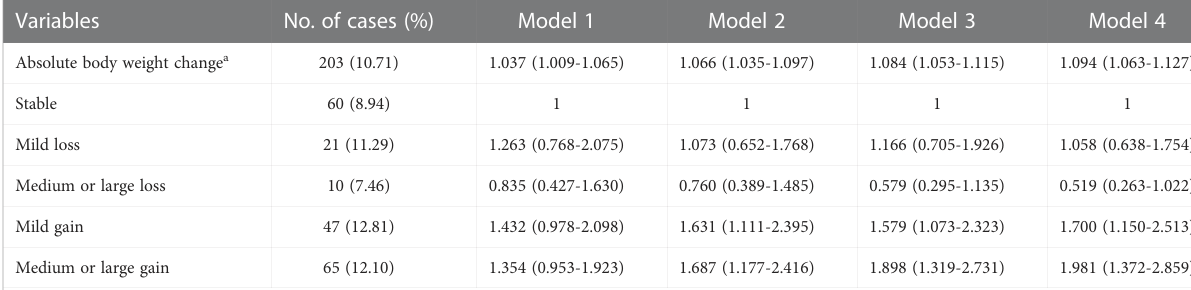
TABLE 2 Associations between absolute body weight change and risk of metabolic abnormalities. Variables